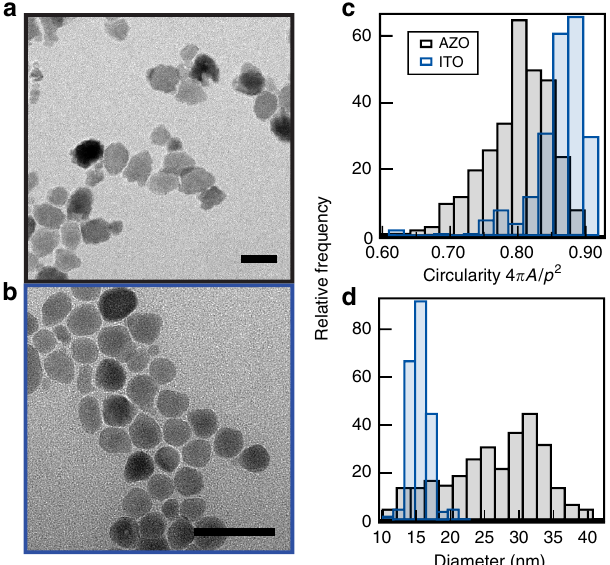
Figure 1 | AZO and ITO nanocrystals structural